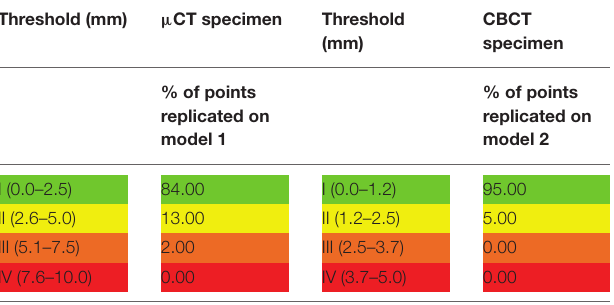
FIGURE 7 | Digital model or STL files of µ CT-based rabbit airway models created in Materialize 3-Matic 13.0 software for dimensional accuracy comparison. The black dots represent the anatomical landmarks chosen for the registration of specimen STL on model STL. (A) µ CT-derived model STL and (B) CBCT-derived model STL.